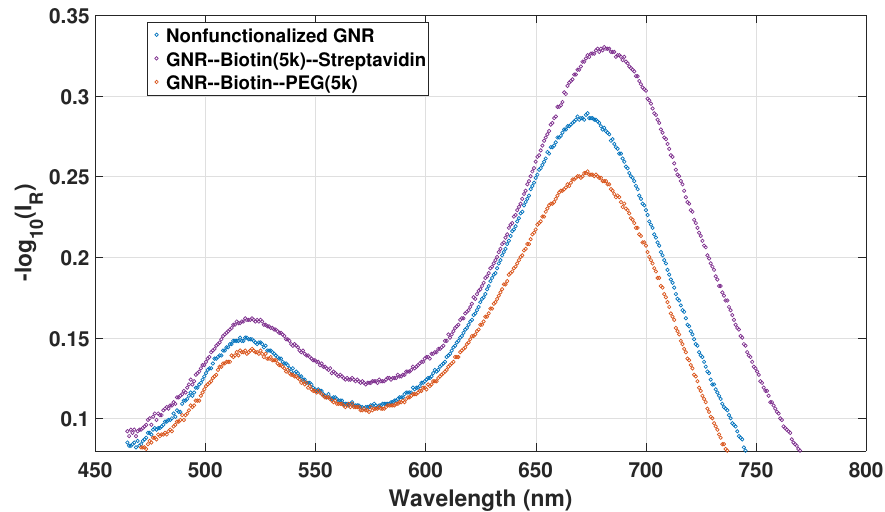
Figure 9. λ II reflectance spectra for bare GNRs, biotin-functionalized GNR and biotin–streptavidin recombination on GNRs in hydrogel in Milli-Q water with pH at 4.5.